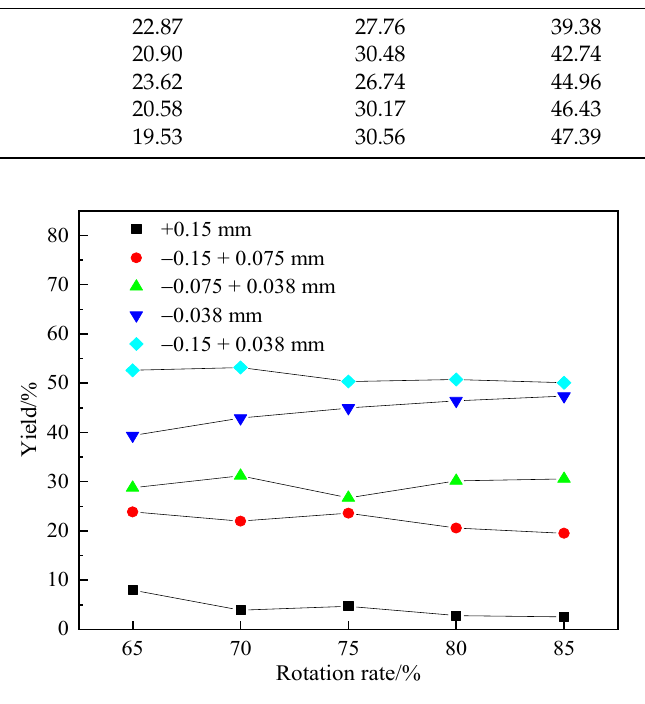
Figure 8. Particle size of grinding product at different rotational rates.